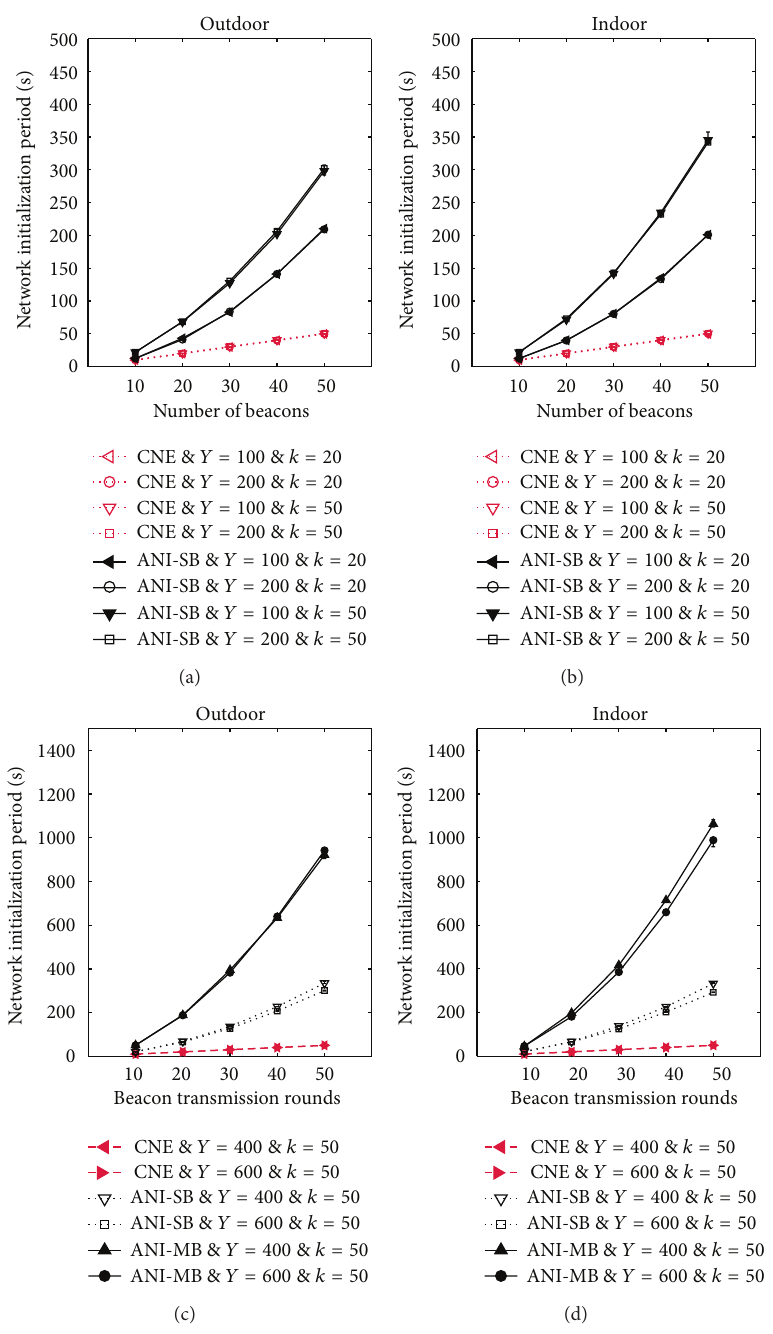
Figure 8: Neighbor discovery and link quality estimation period by ANI-SB, ANI-MB, and CNE protocols in multihop topology networks deployed in outdoor and indoor